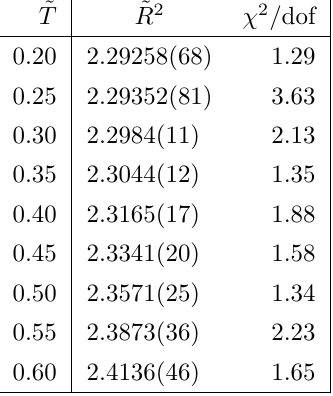
Table 5. Continuum large- N values for ~ R 2 of the bosonic ungauged theory. Reduced (cid:31) 2 values are also reported. Extrapolations at ~ T = 0 : 25 have a larger-then-usual (cid:31) 2 = dof (cid:6)